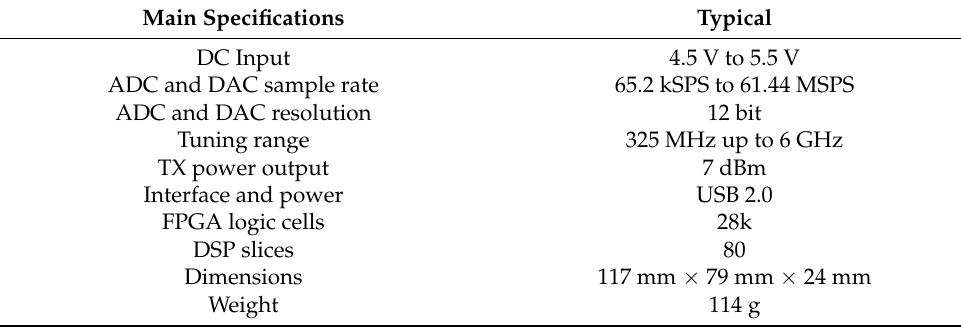
Table 1 is a summary table of all the main features. Table 1. Main specifications of Analog Devices ADALM